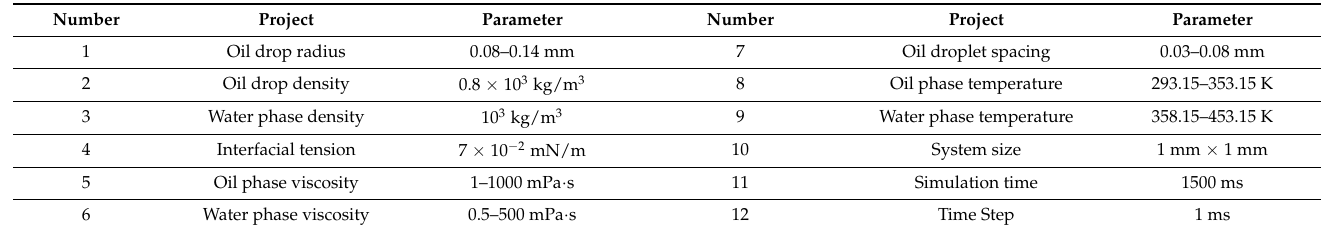
Table 1. The physical and geometric parameters of oil droplet aggregation and simulation.